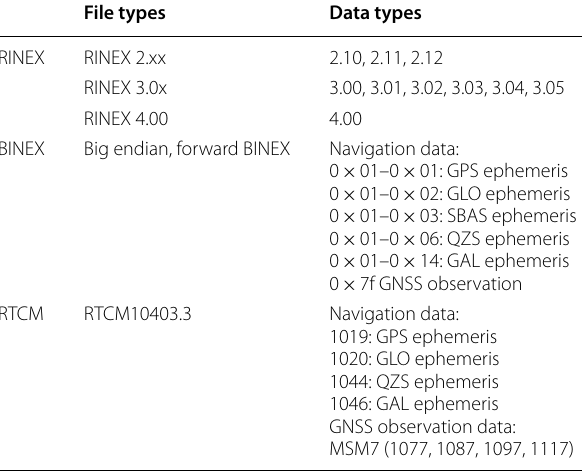
Table 2 Supported file types, data types of the RINGO